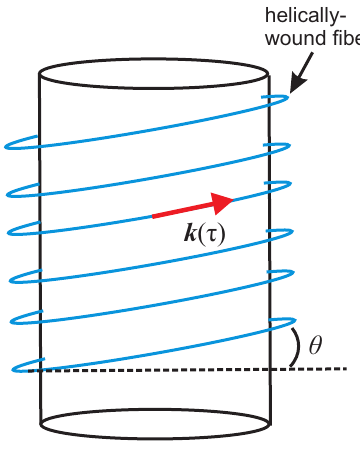
Figure 2. A fiber is wound into a helix of pitch angle θ . The momentum vector k ( τ ) of the light points along the axis of the fiber at each point, and rotates as one moves along the fiber, causing the accumulation of a geometric phase. τ parameterized the position along the